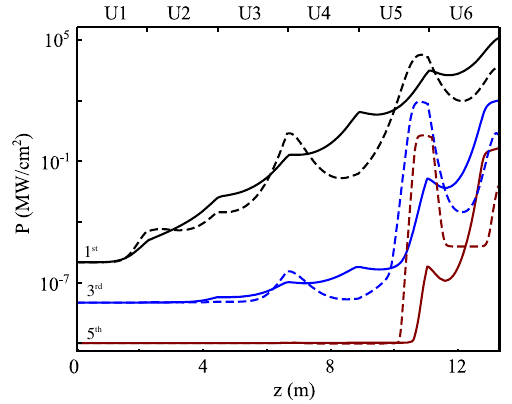
FIG. 8. Power evolution of the fundamental, third and fifth harmonics (line 1st, 3rd, 5th respectively) along the undulator. The simulation has been carried out for both the matching (solid line) and the transport option (dotted line).The e-beam parameters at the linac exit are reported in Table